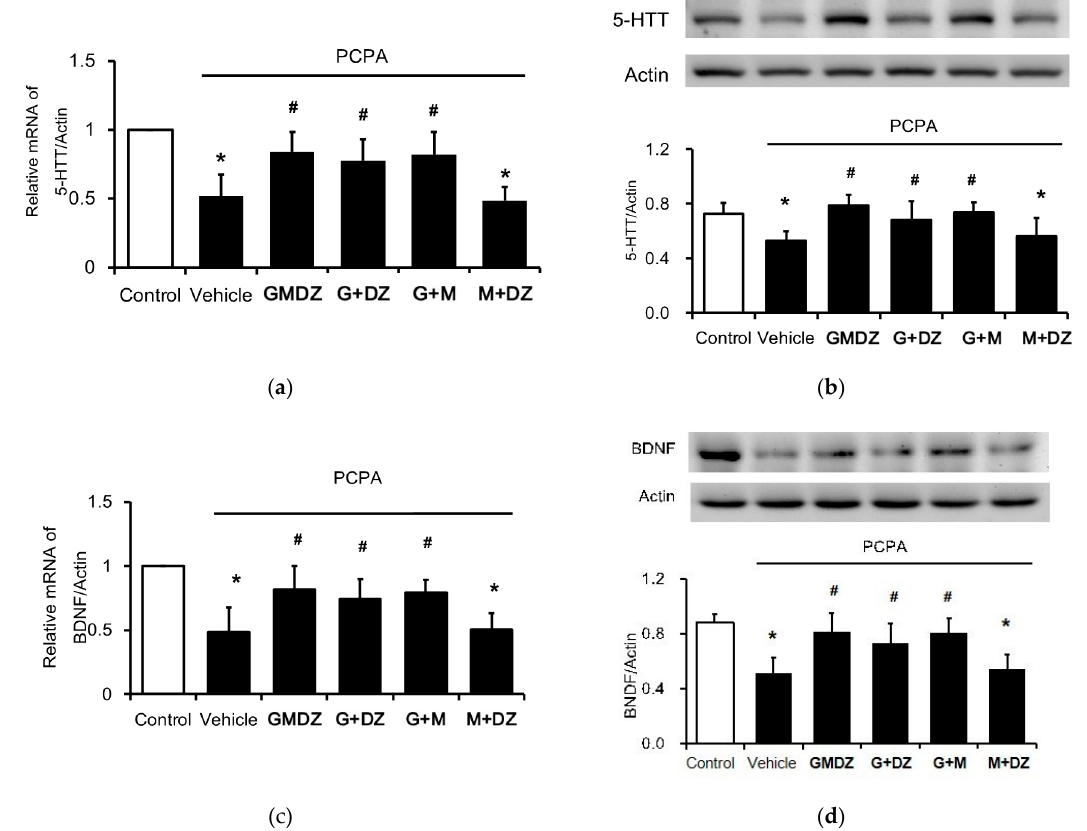
Figure 3. Effects of GMDZ and the one plant-deleted mixture of GMDZ on the expressions of 5-HTT and BDNF in the hippocampus. ( a ) The mRNA levels of 5-HTT; ( b ) The protein levels of 5-HTT; ( c ) the mRNA levels of BDNF; ( d ) the protein levels of BDNF. Data are expressed as mean ± SE ( n = 8). * p < 0.05 compared with the normal control; # p < 0.05 compared with vehicle-treated group.